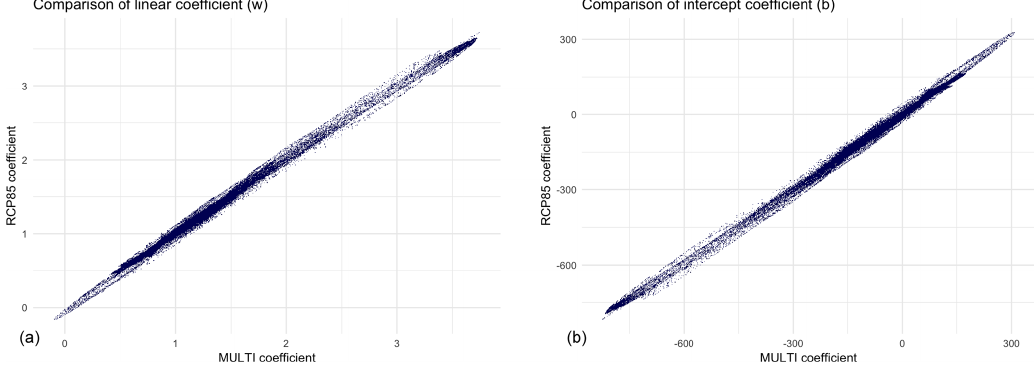
Figure 9. Comparison between coefficients of the mean response model for the RCP85 and MULTI emulators. For both the linear term w (a) and the intercept term b (b) the two models are nearly